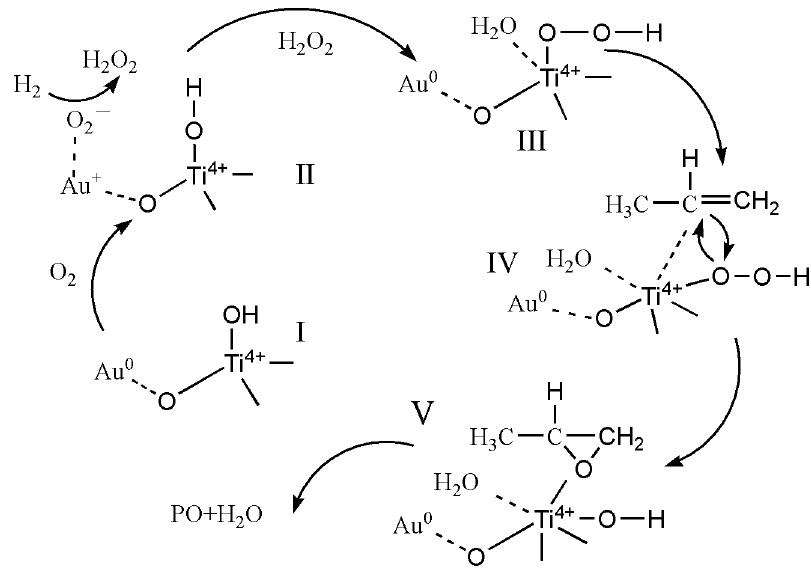
Figure 7. Possible sequence of steps for propylene epoxidation with H 2 and O 2 on Au-supported